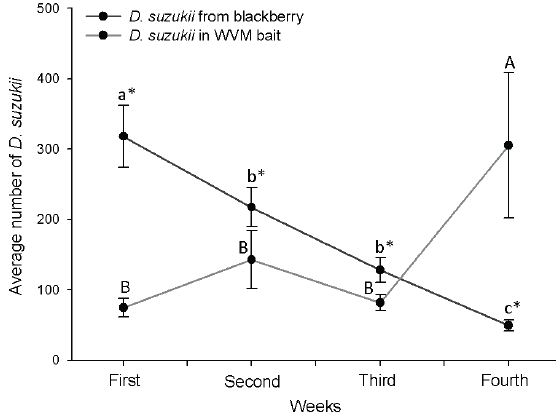
Figure 2 - Means ± standard error (count) of Drosophila suzukii adults emerged from blackberry fruit and captured with the bait mixture Wine + Vinegar + Molasses (WVM). Means sharing the same lower case letter or the same capital letter are not significantly different. Mean contrasts of the Generalized Linear Model following the Poisson